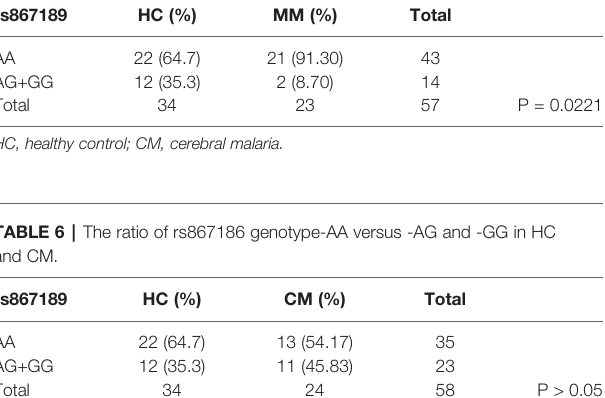
TABLE 5 | The ratio of rs867186 genotype-AA versus -AG and -GG in HC and MM. rs867189